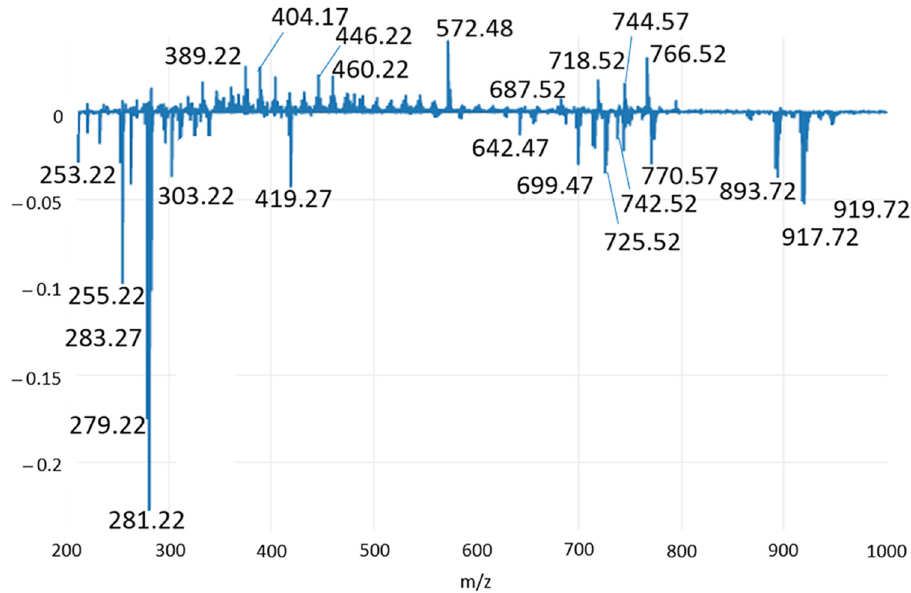
Figure 6. Loading plot relative to the PC2 component, explaining the 30.02% of the total variance of the model.